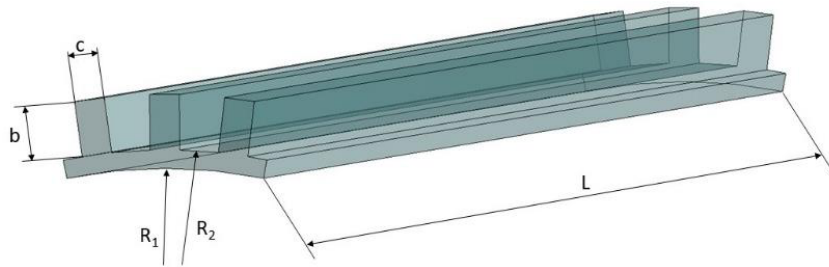
Figure 2. Presentation of the air-gap defining dimensions.